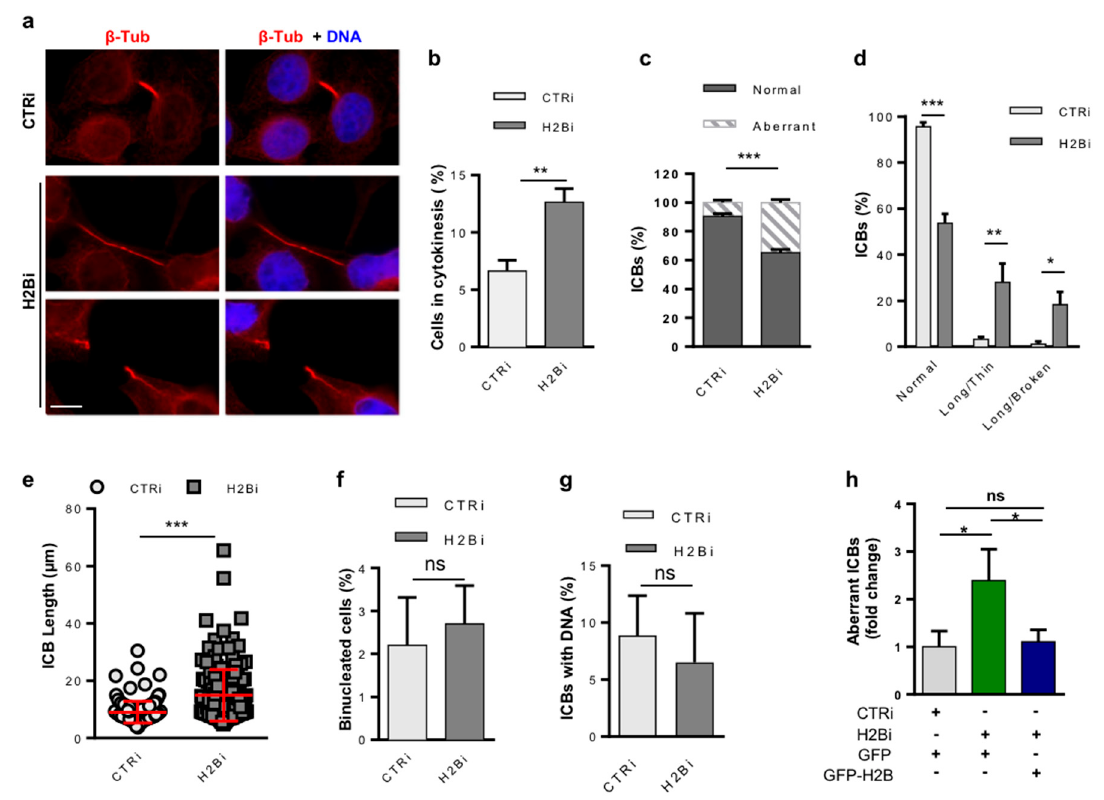
Figure 2. ecH2B depletion in HeLa cells induces cytokinesis defects. Proliferating, asynchronous HeLa cells were depleted for histone H2B, stained for β -Tubulin and DNA as described in Figure 1, and analyzed in panels A to F. ( a ) Representative IF images of cytokinetic cells. Compared to normal cytokinesis in CTRi (upper panels), the presence of long and thin (middle panels) or long and broken (lower panels) ICBs are shown in the H2Bi cells. Scale bar is 10 µ m. ( b ) The percentage of cells in cytokinesis was measured by scoring at least 1000 cells per IF sample in four independent experiments. ( c,d ) The relative amount of normal and aberrant ICB was measured by scoring at least 1000 cells per sample and pooling ( c ) or subdividing ( d ) cytokinetic cells based on the defect type. ( e ) The length of each ICB was measured in three independent experiments. ( f ) The presence of cells with two or more nuclei and ( g ) ICBs with DNA (i.e., chromosome bridges, lagging chromosomes) was measured by scoring the same samples described in (b). ( h ) H2Bi and CTRi HeLa cells were transfected with GFP-H2B or GFP-empty vector and stained for β -Tubulin and DNA as above. The amount of long, aberrant ICB was measured by scoring at least 100 GFP-positive cells per sample. Data are reported as mean ± SD. ns p > 0.05; * p < 0.05; ** p < 0.01; *** p < 0.001. To evaluate whether the ecH2B function in cytokinesis is linked to a specific H2B isoform, we transfected HeLa cells with each single, isoform-specific siRNA (Figure 1a) and measured the